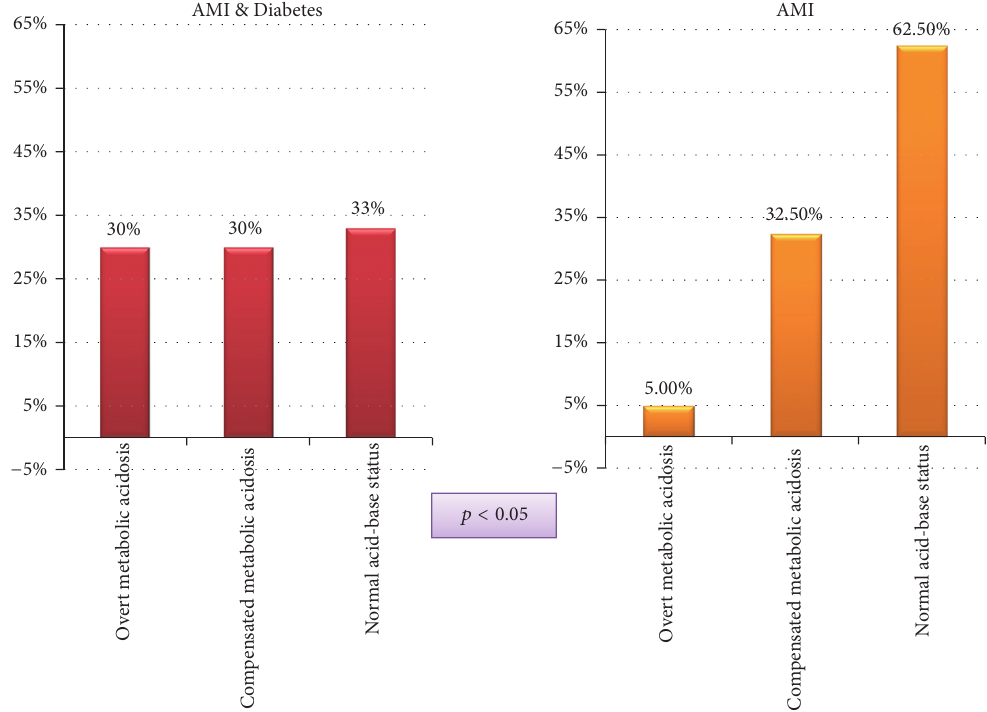
Figure 1: The distribution of acid-base disturbances among the patients with acute myocardial infarction and diabetes mellitus (AMI & Diabetes) and patients with acute myocardial infarction and normal glucose metabolism (AMI).